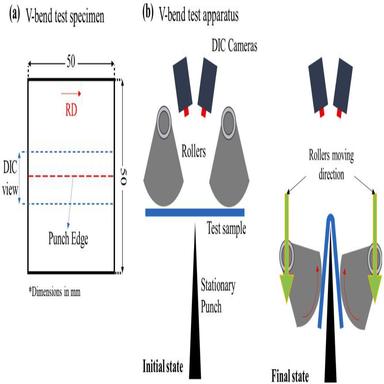
V-bend test specimen and schematic of the inverted V-bend testing apparatus.